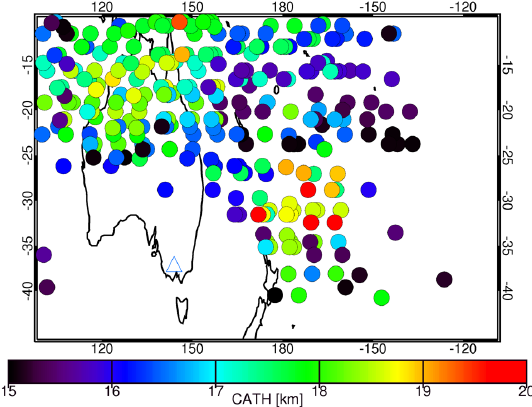
Fig. 8. Map of MIPAS CATH between 15km and 20km for 7 February to 16 February 2009 over Australia and New Zealand. The blue triangle indicates the position of Victoria (located at 38 ◦ S, 143 ◦ E) where the Black Saturday bushfires originated.